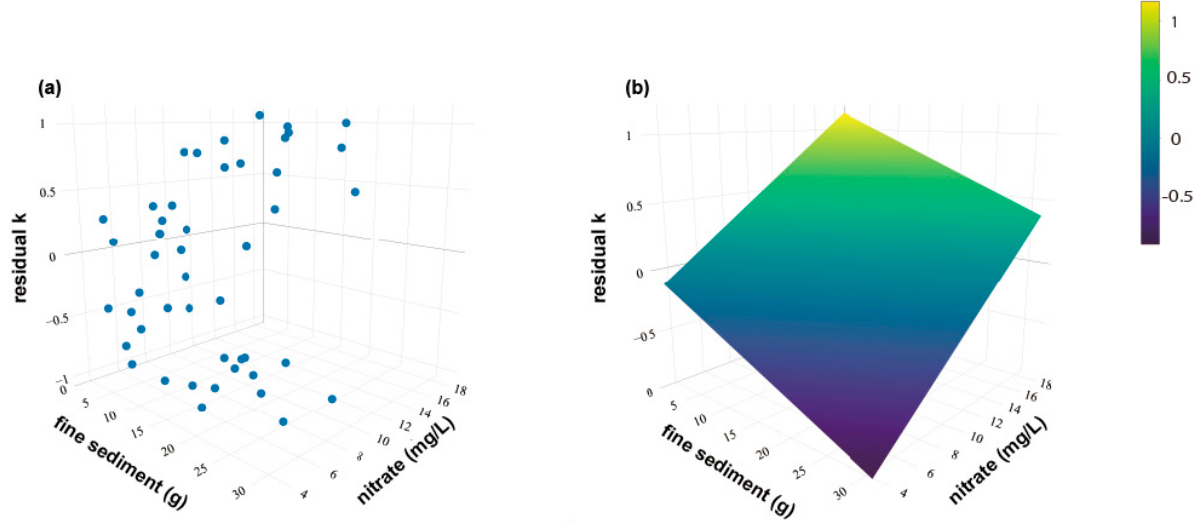
Figure 4. A three-dimensional plot for raw residual k in relation to nitrate and fine sediment ( a ) and a projected surface model based on the results of GLMM ( b ).